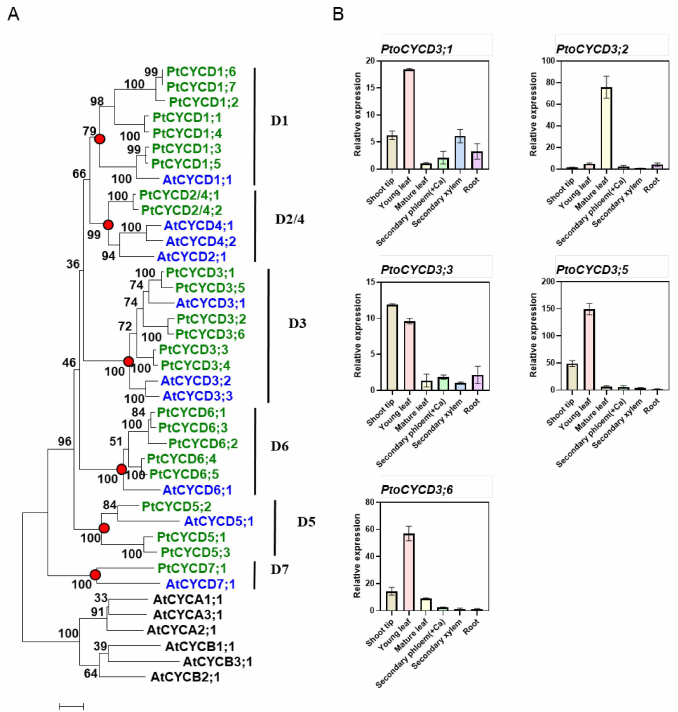
Figure 1. CYCD3 gene identification and expression pattern in Populus . ( A ) Phylogenetic tree of Populus and Arabidopsis D-type cyclin (CYCD) members. ( B ) RT-qPCR analysis of PtoCYCD3 expression profile in various Populus tissues. Ca: Cambium. The expression in each sample was normalized using Populus Actin (GenBank number XM_002316253) as an internal control. The values are means ± SE, n = 3. Phylogenetic trees were constructed using maximum-likelihood (ML) method in PHYML software with the Whelan and Goldman (WAG) amino acid substitution model. The proportion of invariable sites (I) and gamma distribution (G) parameter was estimated, and the bootstrap replicates were set to